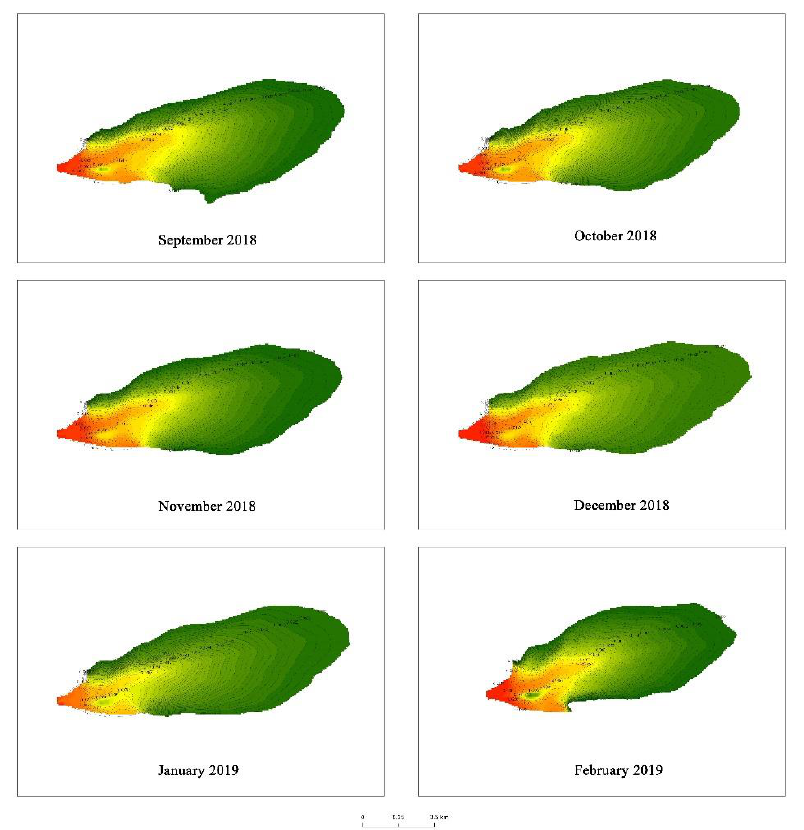
Water 2020 , 12 , 674 Figure A1. Distribution of flow velocities of the Fu River–Baiyangdian Lake transition zone.